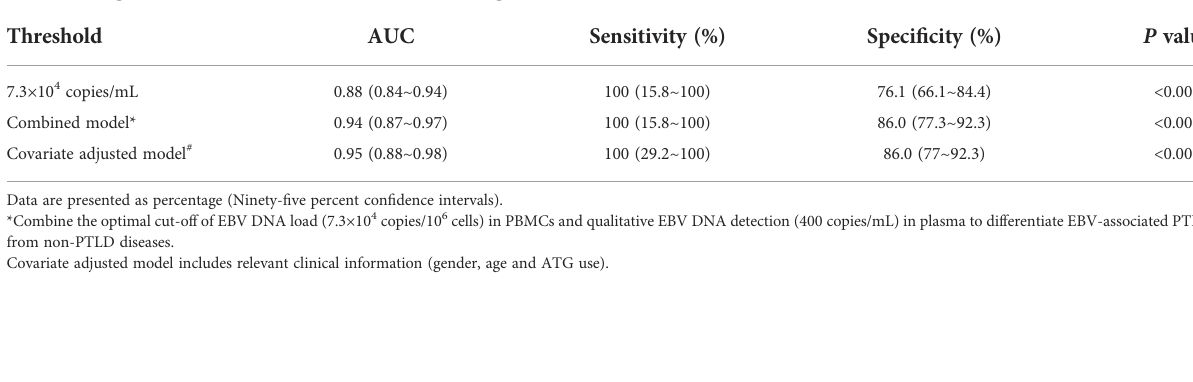
TABLE 2 Diagnostic value of the validation cohort including 3 cases of PTLD diseases and 92 cases of non-PTLD